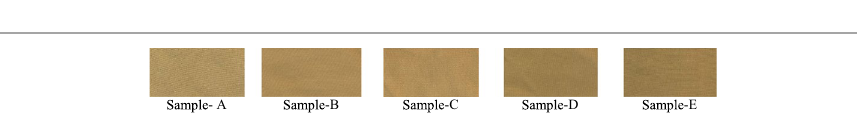
Fig. 1 The gradual increment of color strength (K/S value at λ max with the increase of temperature